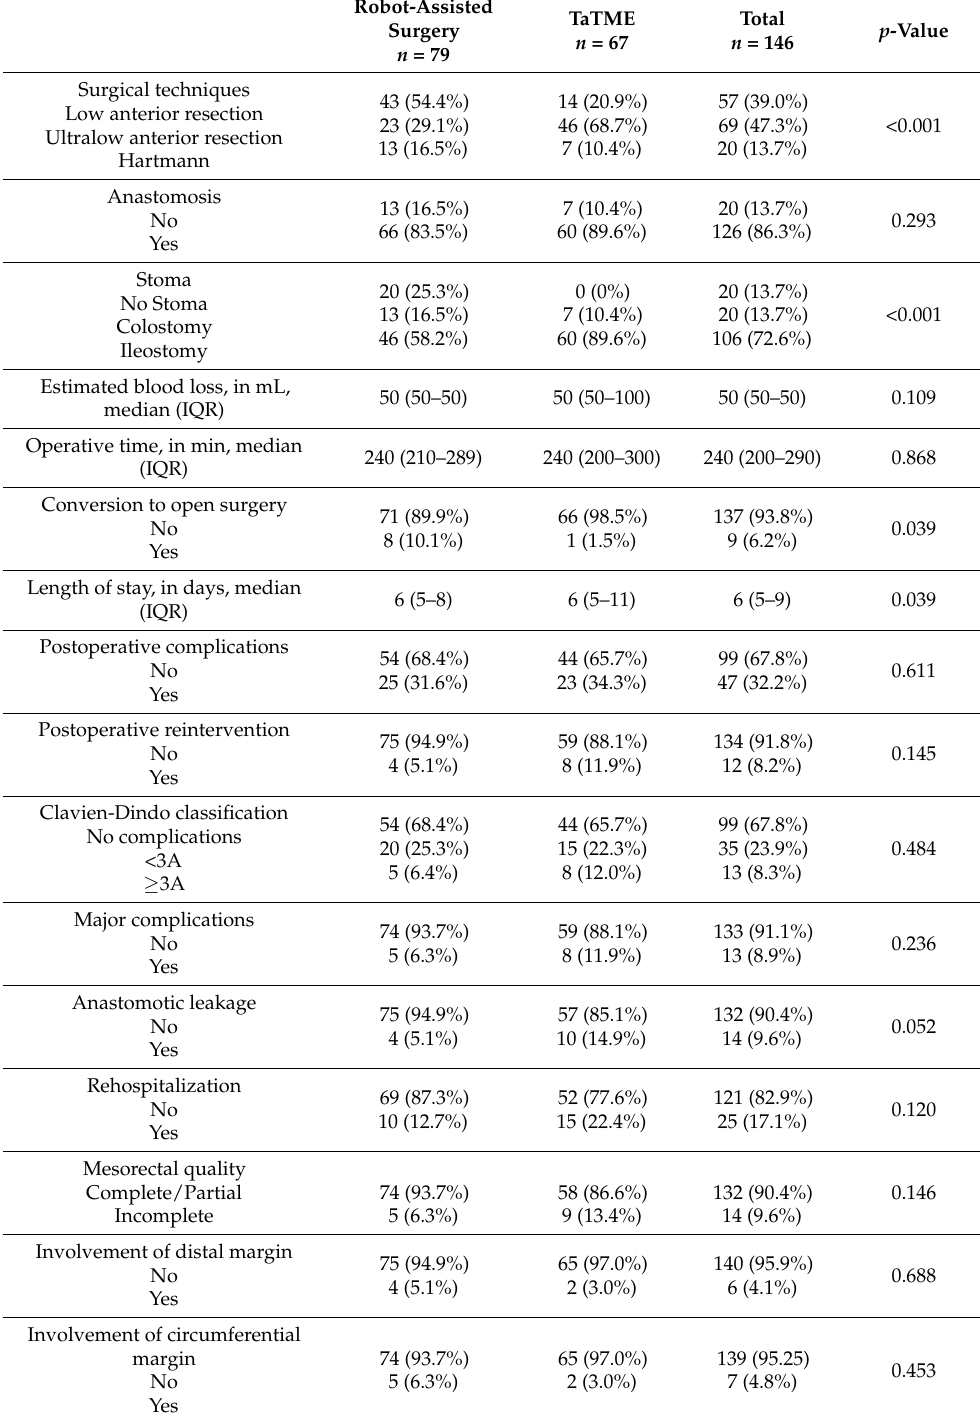
Table 2. Surgical, postoperative, and oncological outcomes of patients who underwent robot-assisted surgery or taTME for rectal